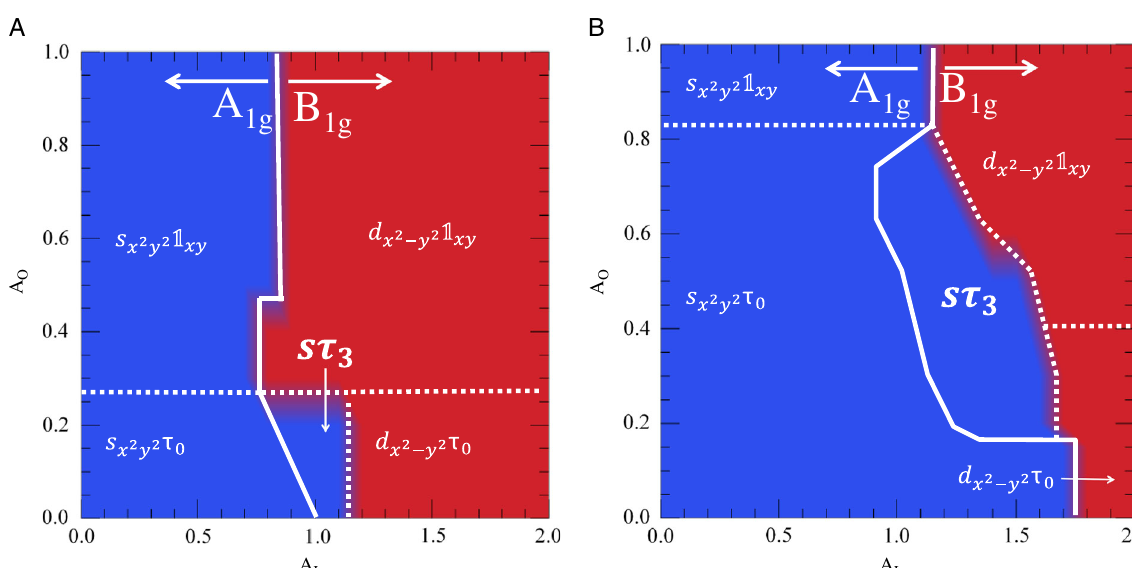
Fig. 2 Phase diagrams based on the leading pairing amplitudes given by self-consistent calculations with fi xed J 2 = 1 and tight-binding parameters appropriate to a alkaline iron selenides and b iron pnictides. The tight-binding parameters used can be found in ref. 27. The blue shaded areas correspond to dominant pairing channels with an s x 2 y 2 form factor, while the red shading covers those with a d x 2 (cid:3) y 2 form factor. The continuous line separates regions where the pairing belongs to the A 1 g and the B 1 g representations, respectively. The 1 × 1 matrix in the d xy subspace is represented by 1 xy . The orbital-selective s τ 3 pairing occurs for A O < 1, A L near 1 in all cases